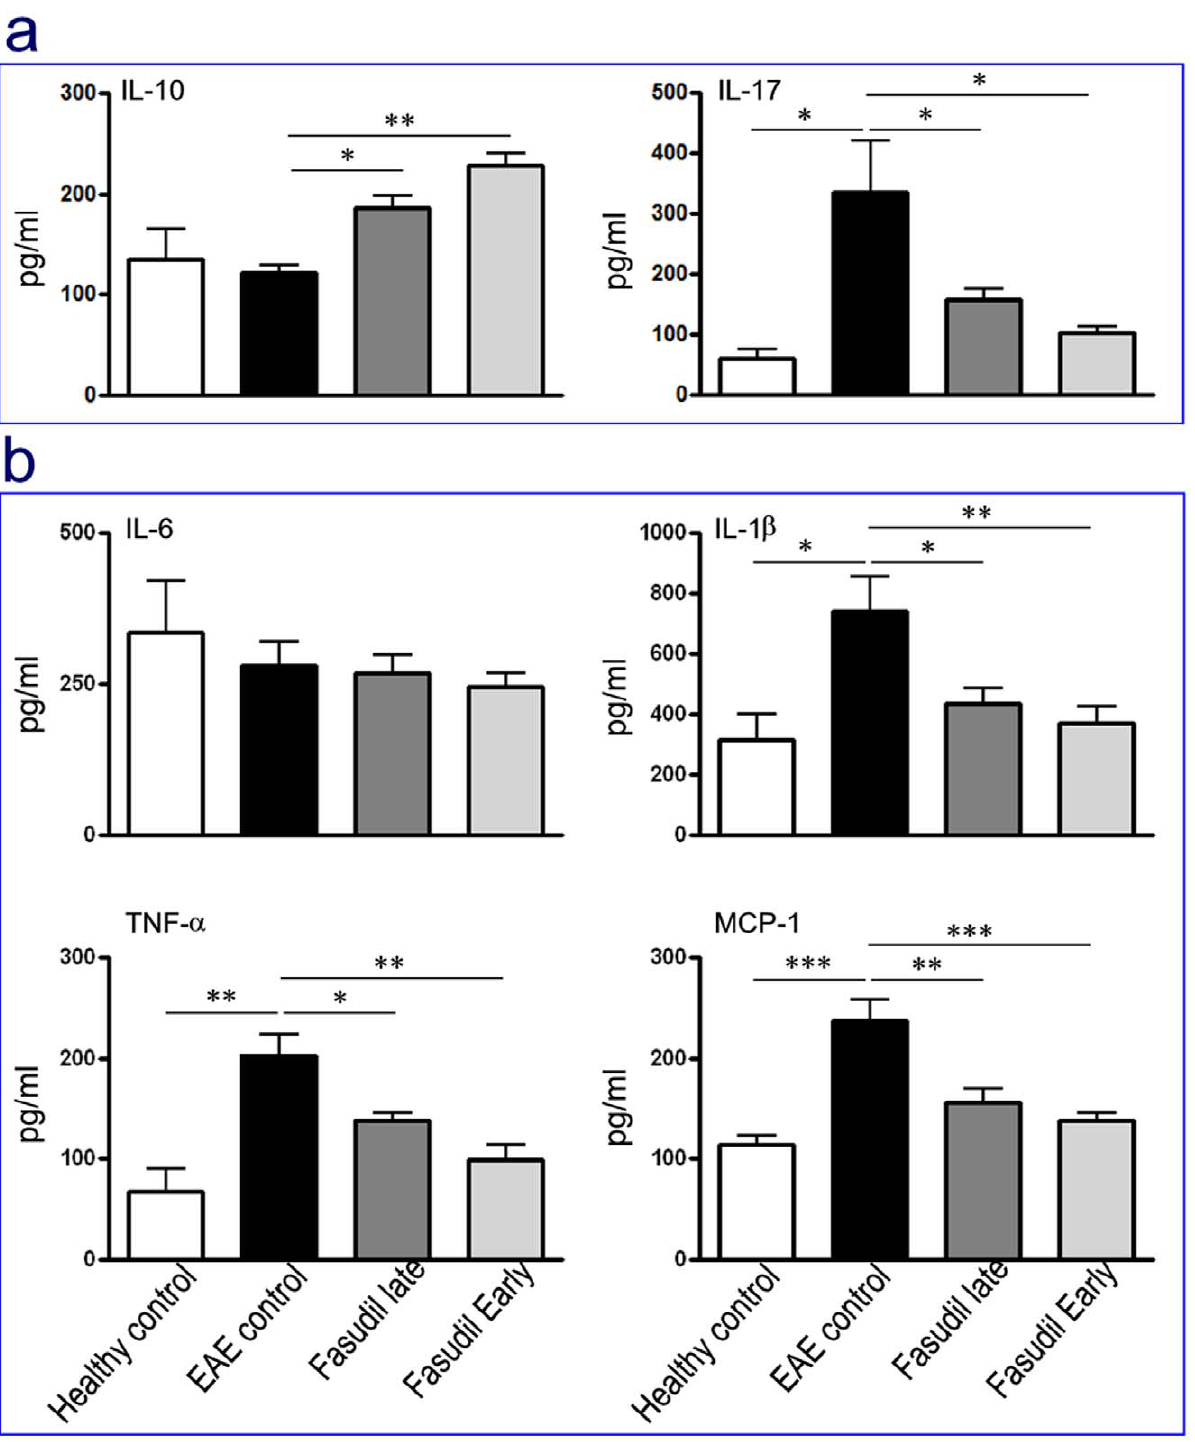
Figure 8. Fasudil inhibits inflammatory molecules. Chronic EAE was induced in C57BL/6 mice with MOG 35–55. Fasudil was injected (i.p.) at 40 mg/kg/d every other day on days 3 and 11 p.i. On day 21 p.i., spleen was obtained, and splenic MNCs were prepared. Splenic MNCs were incubated for 48 h at 37 u C in the presence of MOG 35–55 (10 m g/ml). Splenic MNCs from healthy mice were measured as control. The supernatants were collected, and the levels of IL-10, IL-17 (a), IL-1 b , IL-6, TNF- a and MCP-1 (b) were measured by ELISA kits. The results were represented as pg/ml, and analyzed from 5 mice in each group. * p , 0.05, ** p , 0.01. doi:10.1371/journal.pone.0054841.g008 air atmosphere, and stained for 20 min at RT in 0.3% saponin/ CD4 and PE-IL-10, PE-IL-12, PE-IL-17 (eBioscience Inc), and 1% BSA-PBS buffer with the following panel of antibodies: FITC- Alexa Fluor 488-anti-F4/80, PE-IL-10, PE-IL-12, anti-iNOS and